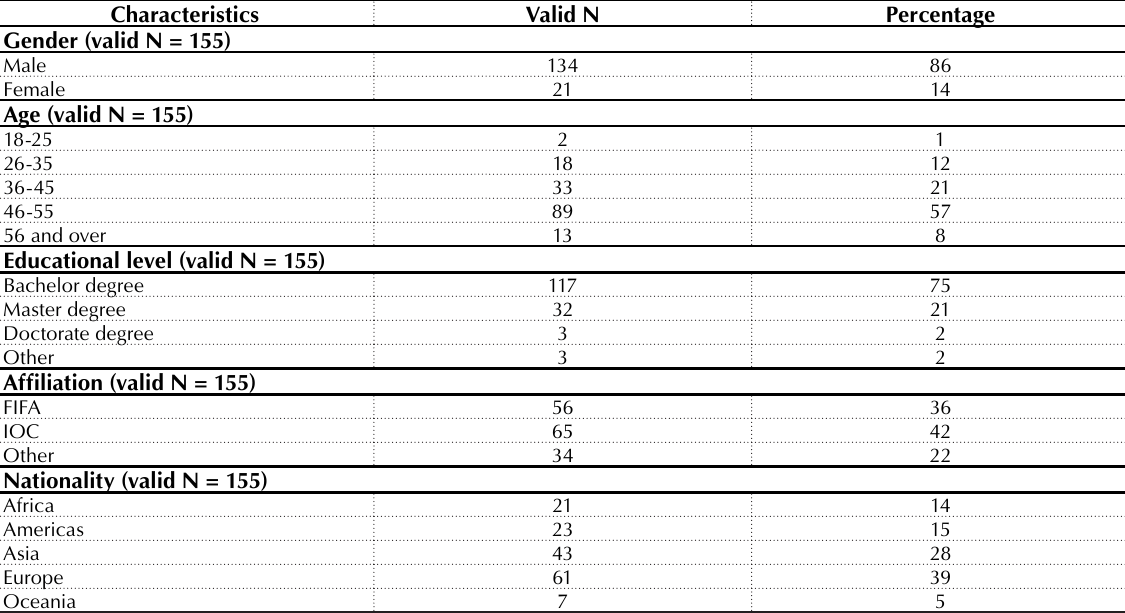
Table 1. Demographic profile of respondents